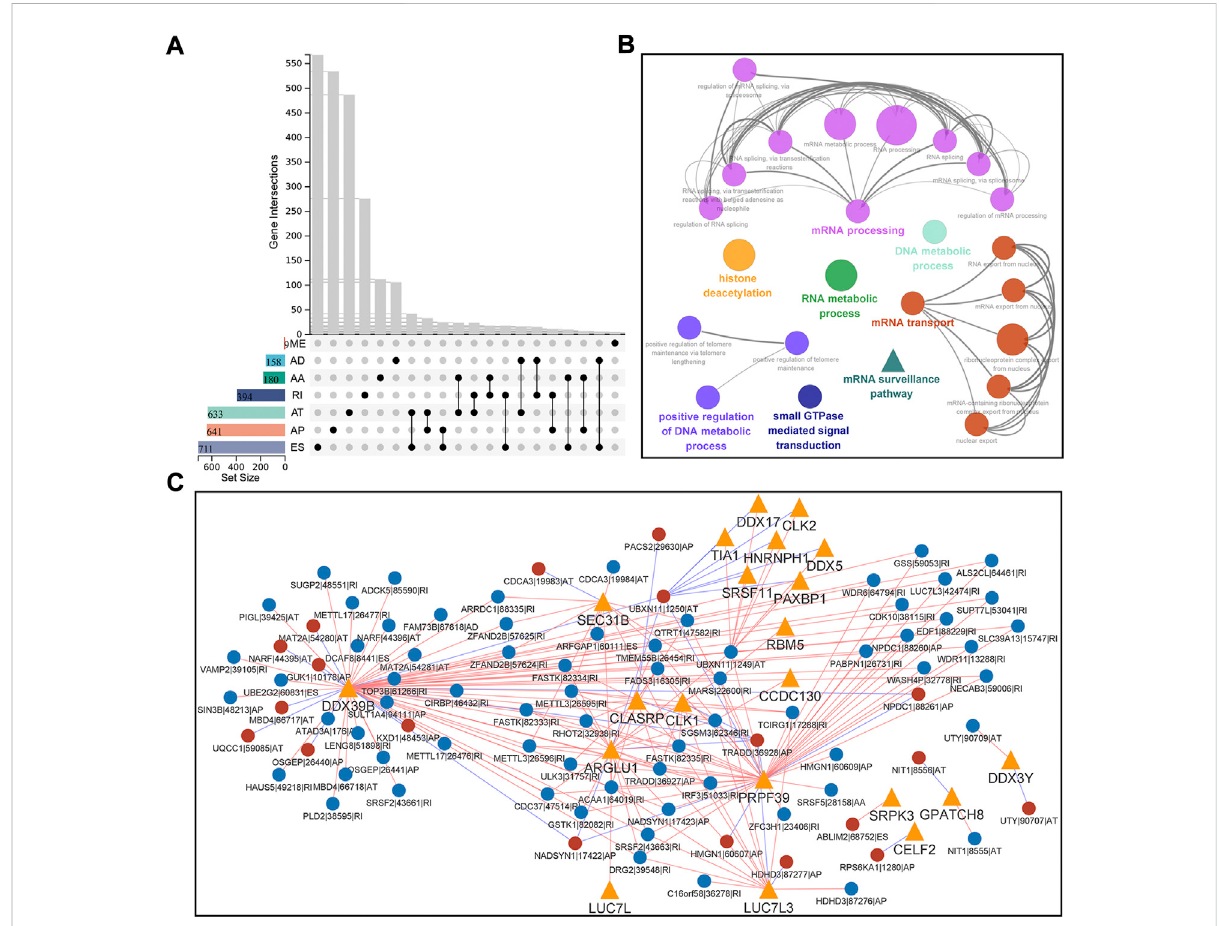
FIGURE 2 Identi fi cation and functional analysis of survival-associated AS events in HNSC. (A) Interactive sets between the seven types of survival- associated AS events ( n = 2726) shown in an UpSet plot. (B) Functionally grouped Gene Ontology (GO) and Kyoto Encyclopedia of Genes and Genomes (KEGG) categories for parent genes of survival-associated AS events. GO and KEGG categories were grouped based on their similarity ( κ - score ≥ 0.5),andthemostsigni fi canttermineachgroupisshowninbold. (C) Correlation networkofsplicingfactorsandsurvival-associated AS events. This network was built based on signi fi cant correlations (|R| ≥ 0.7, p < 0.001) between the expression of 71 splicing factors and the PSI values of survival-associated AS events. Splicing factors are represented with orange triangles, and AS events are represented with circulars (red/blue represents favorable/inferior prognosis). The red/blue lines are represented with positive/negative correlation. Data were analyzed using Pearson ’ s correlation